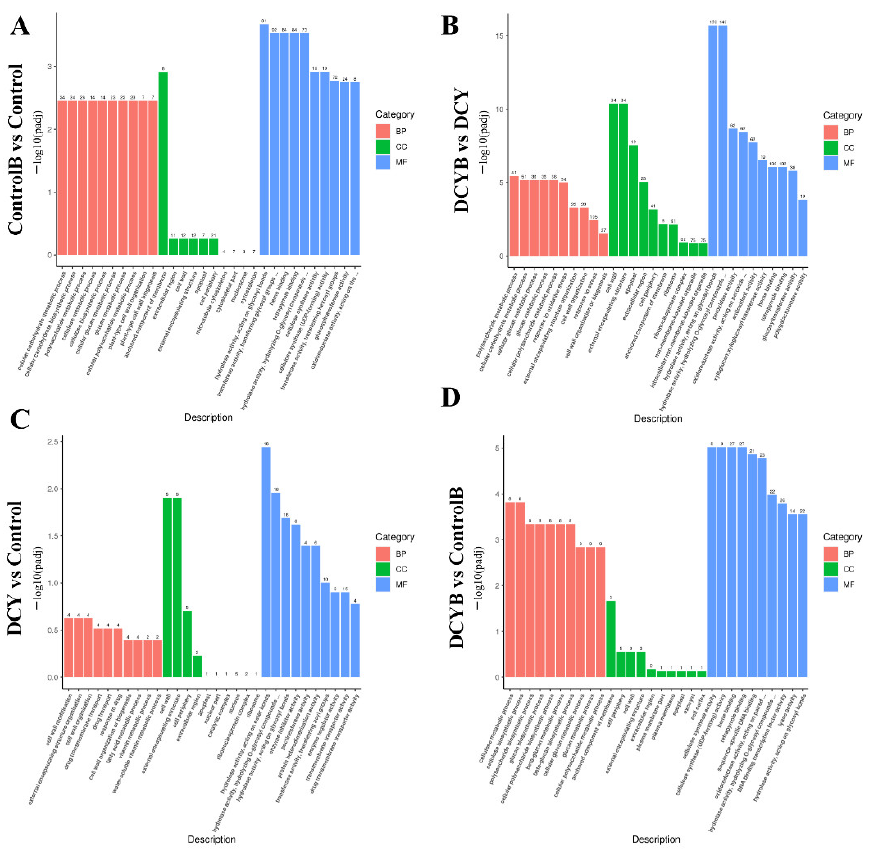
Figure 5. GO annotation classification chart of DEGs in different comparative groups. ( A ) ControlB vs. control: the group of DEGs between control + BPH and control rice plants; ( B ) DCYB vs. DCY: the group of DEGs between DCY + BPH and DCY rice plants. ( C ) DCY vs. control: the group of DEGs between DCY and control rice plants; ( D ) DCYB vs. controlB: The group of DEGs between DCY + BPH and control + BPH rice plants. The x-axis was functional classification, the y-axis was − log10 (padj). BP: biological process, CC: cellular component, MF: molecular function.